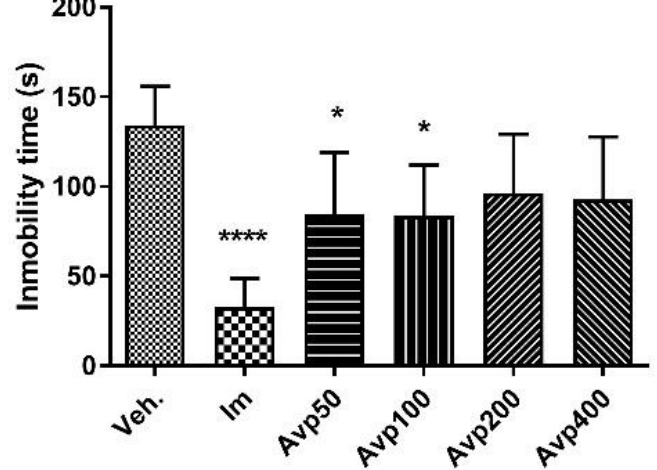
Figure 6. Immobility time (s) in the tail suspension test for the groups ( n = 6) treated orally for 7 days with Aloysia virgata var. platyphylla (Avp). Im.: imipramine. Veh: tween 80, 10%. The data correspond to the mean ± SD. One-way ANOVA and Dunnett’s post hoc test were performed. * p < 0.05; **** p < 0.0001.